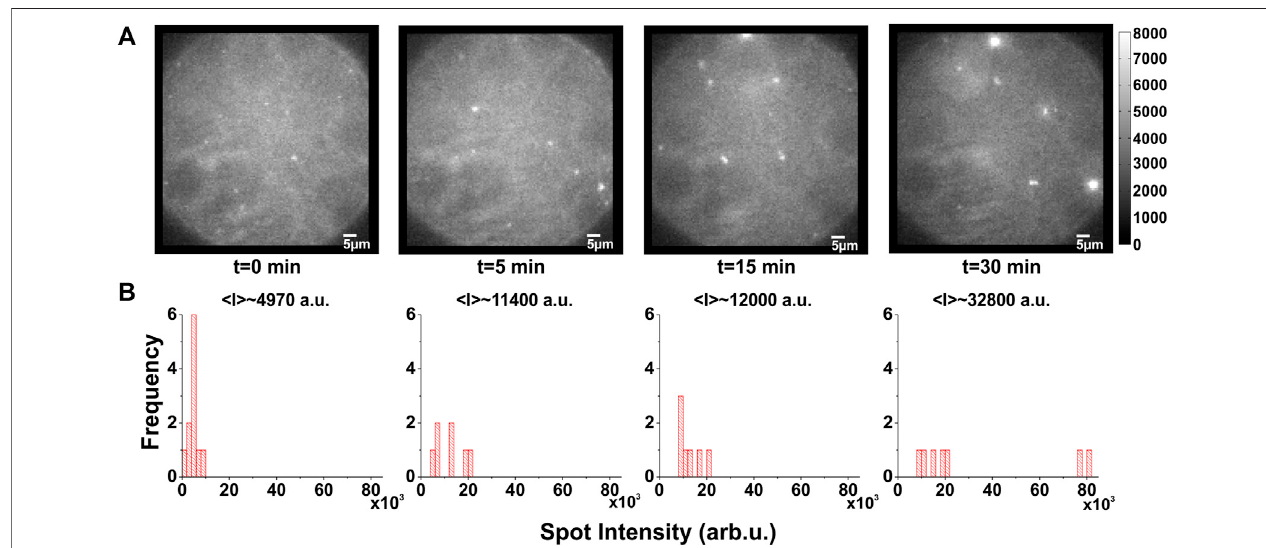
FIGURE 2 | Temporal evolution of KcsA clustering. (A,B) , Example of typical time course of clustering: (A) , images taken from a DPhPC/decane bilayer in which labeled KcsA channels were fused show that clustering appears more and more prominent over time. (B) , the corresponding spot intensity distribution con fi rms a shift towards clustered spots, although some could remain individual. Excitation light was restricted to the central area of the bilayer in order to prevent scattering from the torus and the chamber. This and inevitable photobleaching meant that the total number of channels is not necessarily